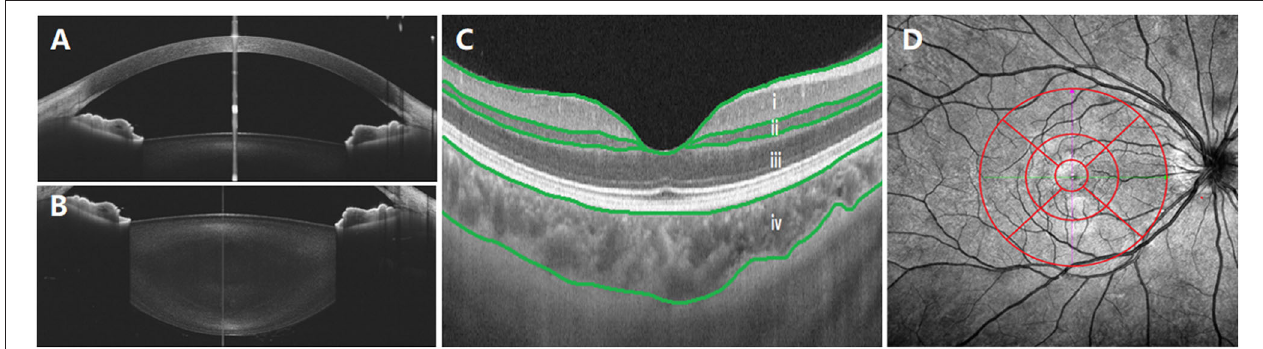
FIGURE 1 | Examination of central corneal thickness (CCT), anterior chamber depth (ACD), lens thickness (LT), choroid, and retina. (A) CCT and ACD; (B) LT; (C) optical coherence tomography (OCT) image. The built-in software in swept-source OCT (SS-OCT) automatically divided fundus structure into four layers: (i) ganglion cell complex (GCC) layer; (ii) inner nuclear layer (INL); (iii) outer retinal layer (ORL); (iv) choroid layer. (D) OCT angiography (OCTA) image. The white vertical line is “corneal reflex” in (A,B) , the red region is the Early Treatment Diabetic Retinopathy Study (EDTRS) grid in (C) . CCT, central corneal thickness; ACD, anterior chamber depth; LT, lens thickness; OCT, optical coherence tomography; SS-OCT, swept-source optical coherence tomography; OCTA, optical coherence tomography angiography; EDTRS, Early Treatment Diabetic Retinopathy